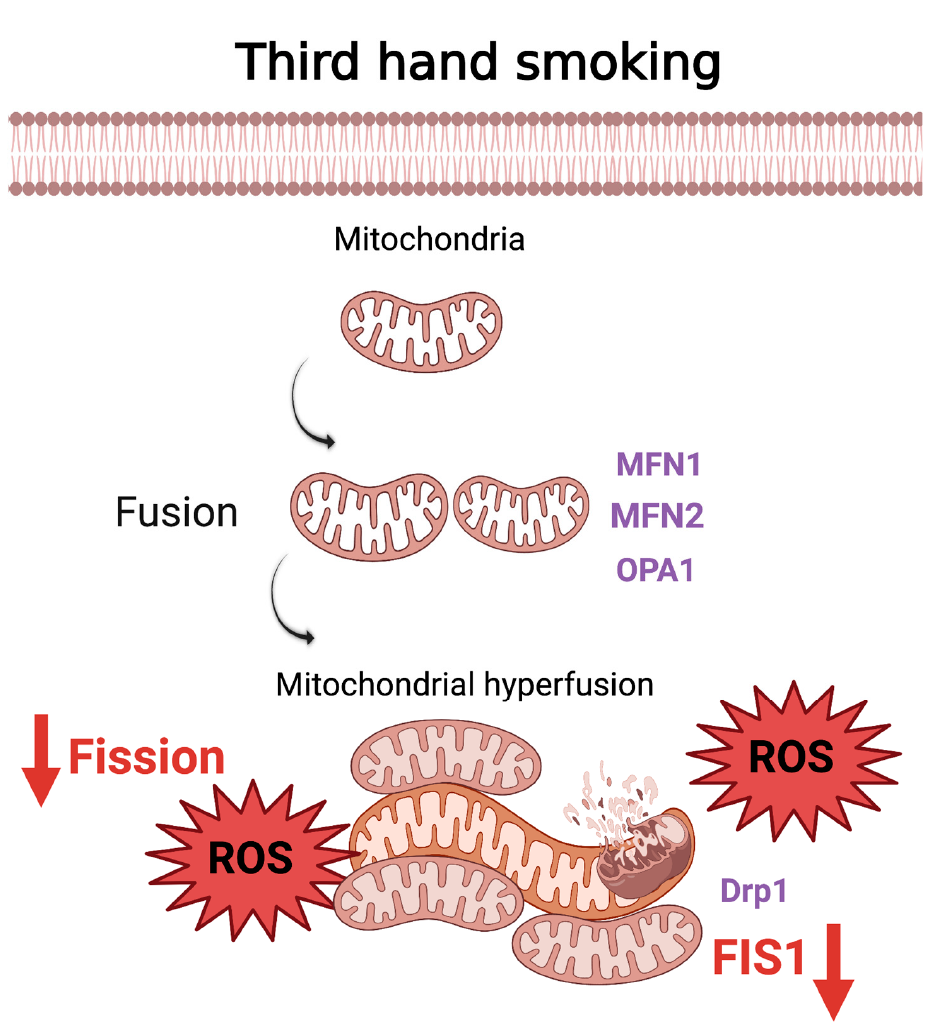
Figure 4. The effect of THS on mitochondria and cell health. THS caused SIMH accompanied by decreased expression of mitochondrial fission protein Fis1 causes the elevation of ROS [110] .